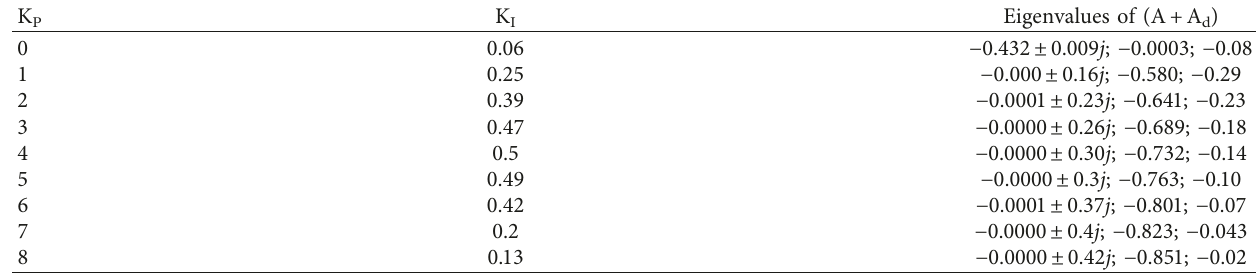
Table 2: For a given P , the maximum integral controller gain.